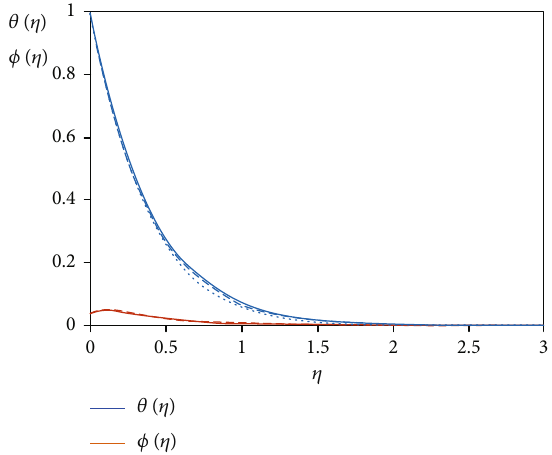
Figure 6: Concentration and temperature pro fi les a ff ected by the Prandtl numbers.